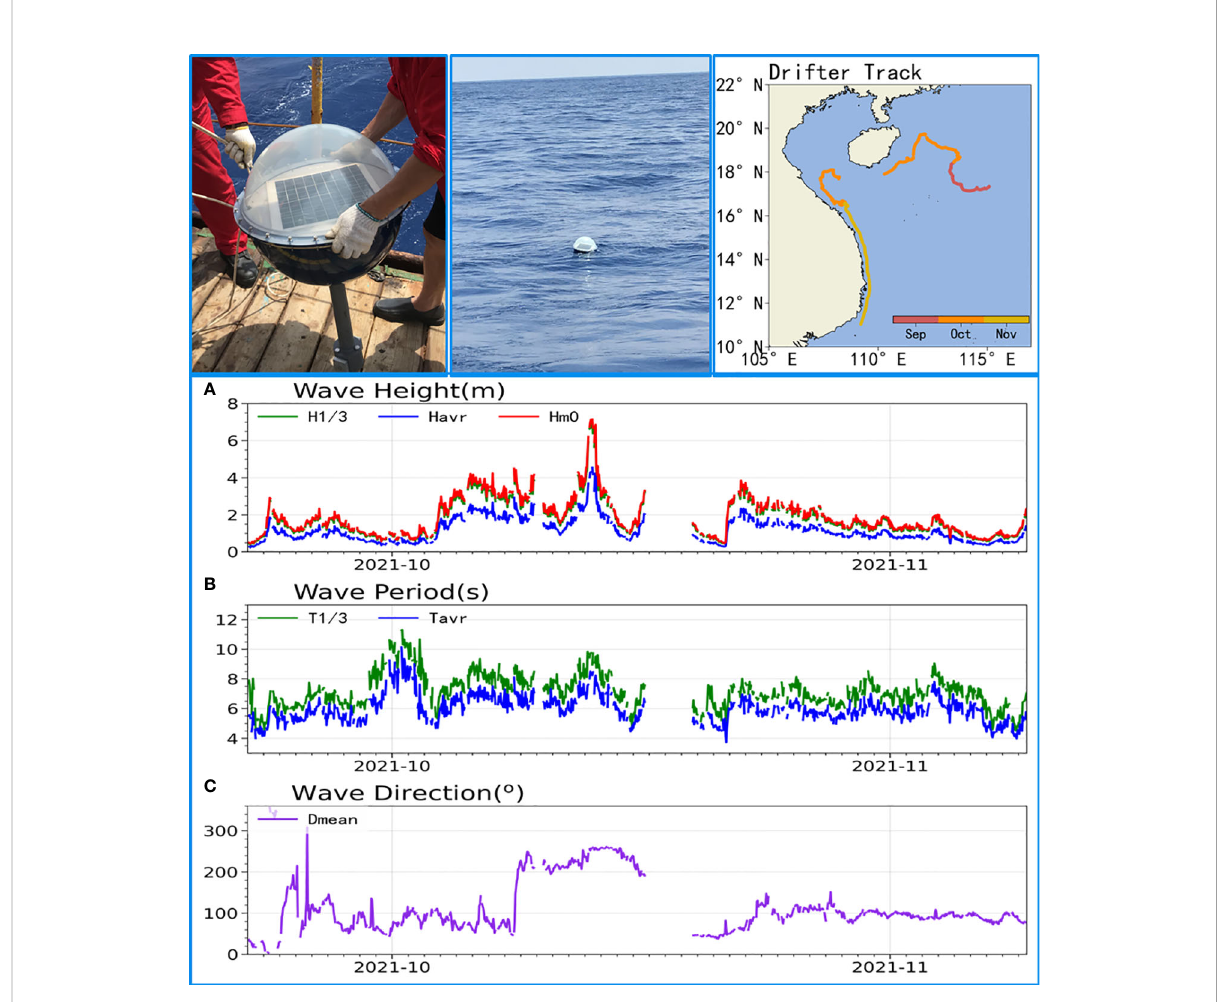
FIGURE 16 Wave observation by a drifter in the South China